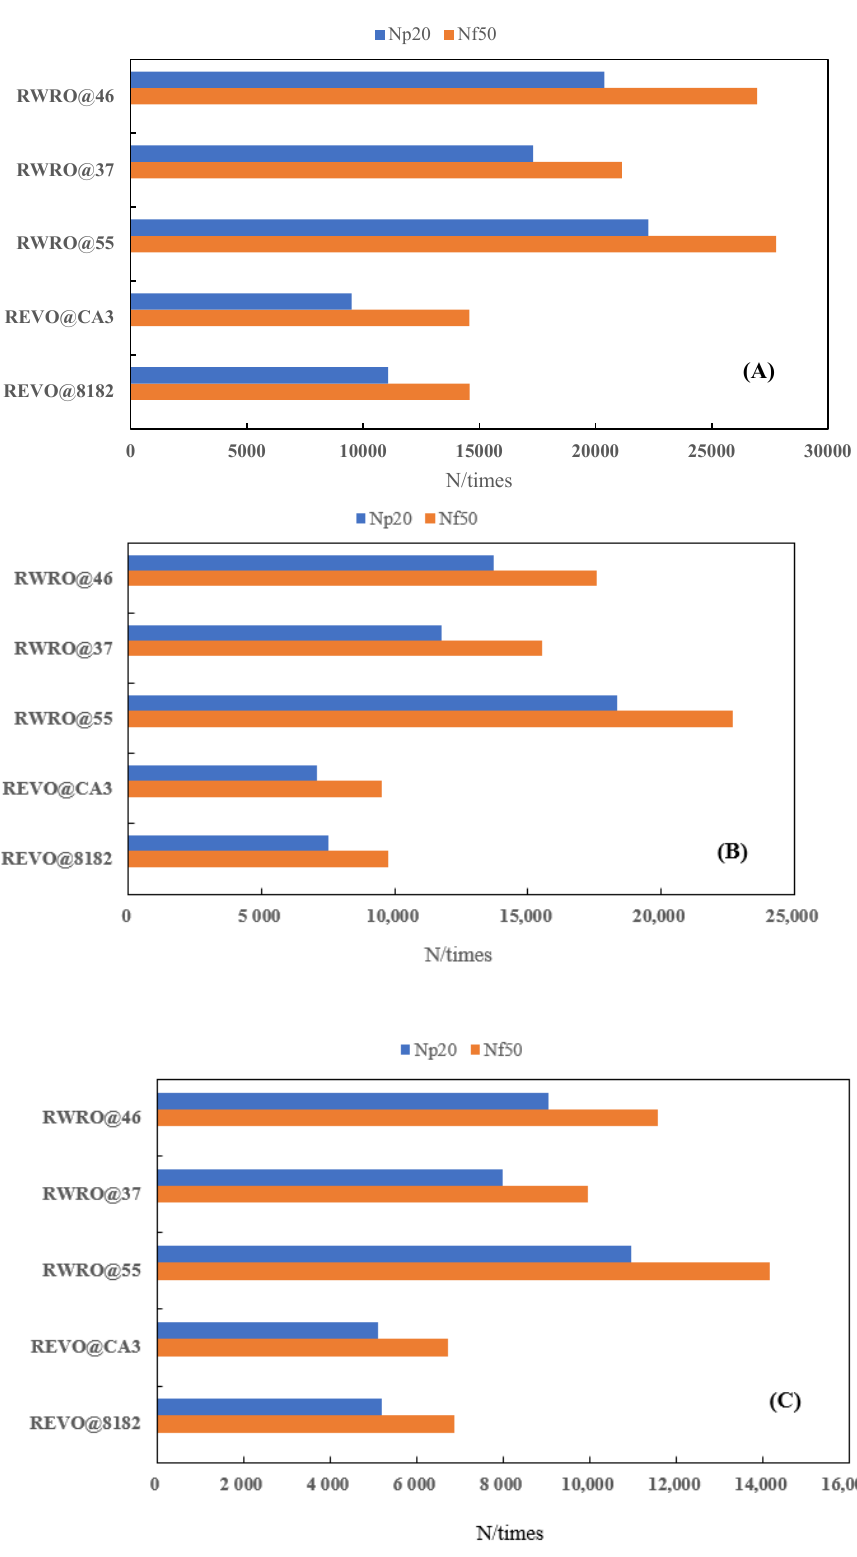
Figure 7. ( A ) Fatigue life of rejuvenated asphalt under 4.5% strain-control. ( B ) Fatigue life of rejuvenated asphalt under 5.5% strain-control. ( C ) Fatigue life of rejuvenated asphalt under 6.5% strain ‐ control.